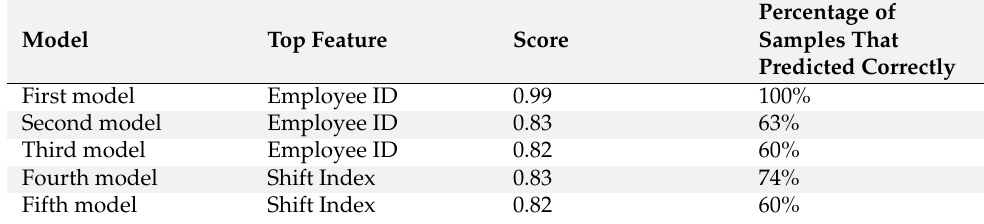
Table 7. Comparison of the